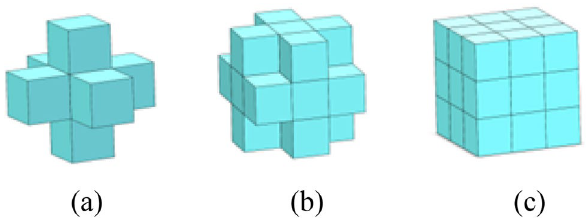
ˆ N = 6 ˆ N = 18 ( b ) 3D Radial, ( c )